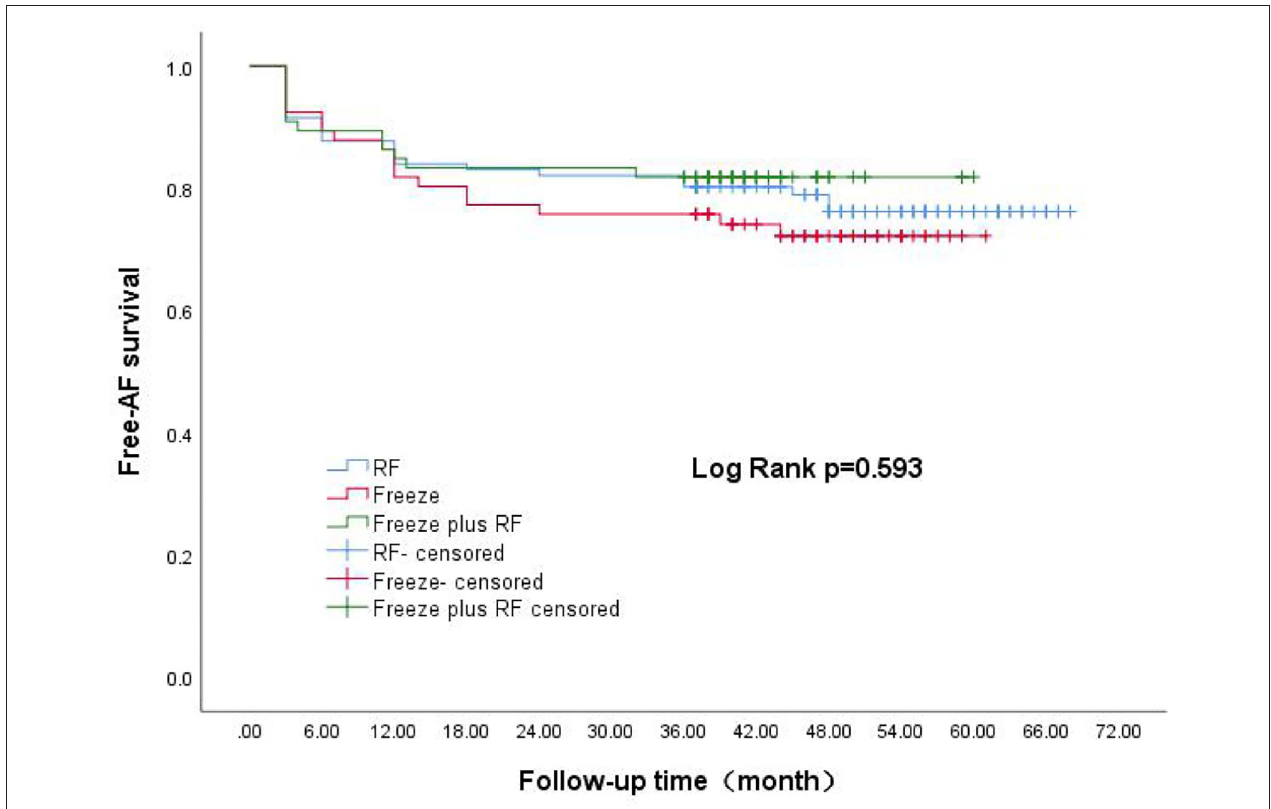
FIGURE 1 | Kaplan-Meier analysis of AF-free rate after three different surgical procedures. AF, atrial fibrillation.